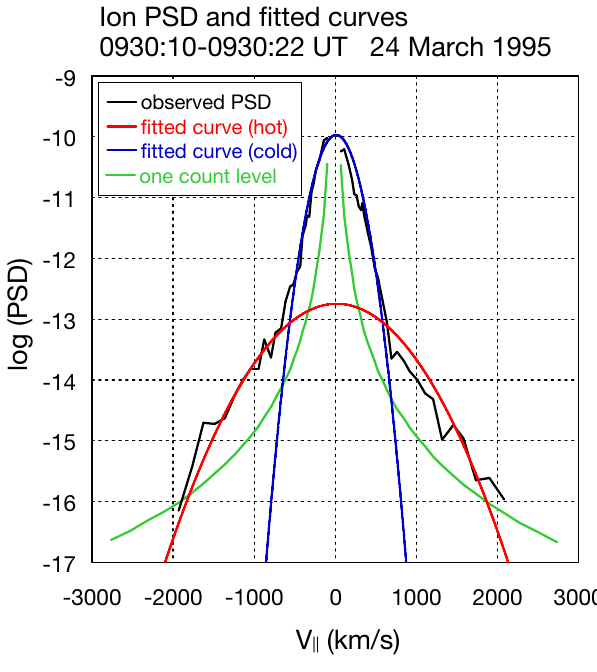
Fig. 3. Comparison between thet observed PSD in the parallel direction and the estimated PSD by the two-Maxwellian mixture model. The black line shows the observed PSD, and the red (blue) curve corresponds to the fitted curve of the hot (cold) component. A couple of green curves are the one-count level of the